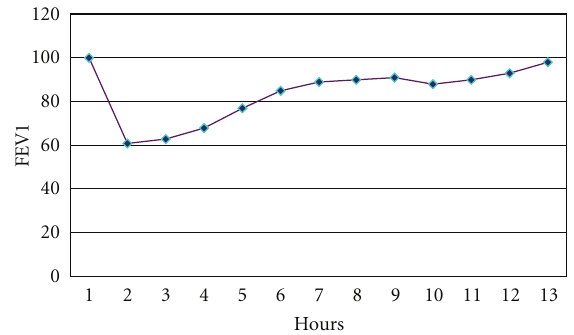
Figure 1: Occupational challenge test with angora